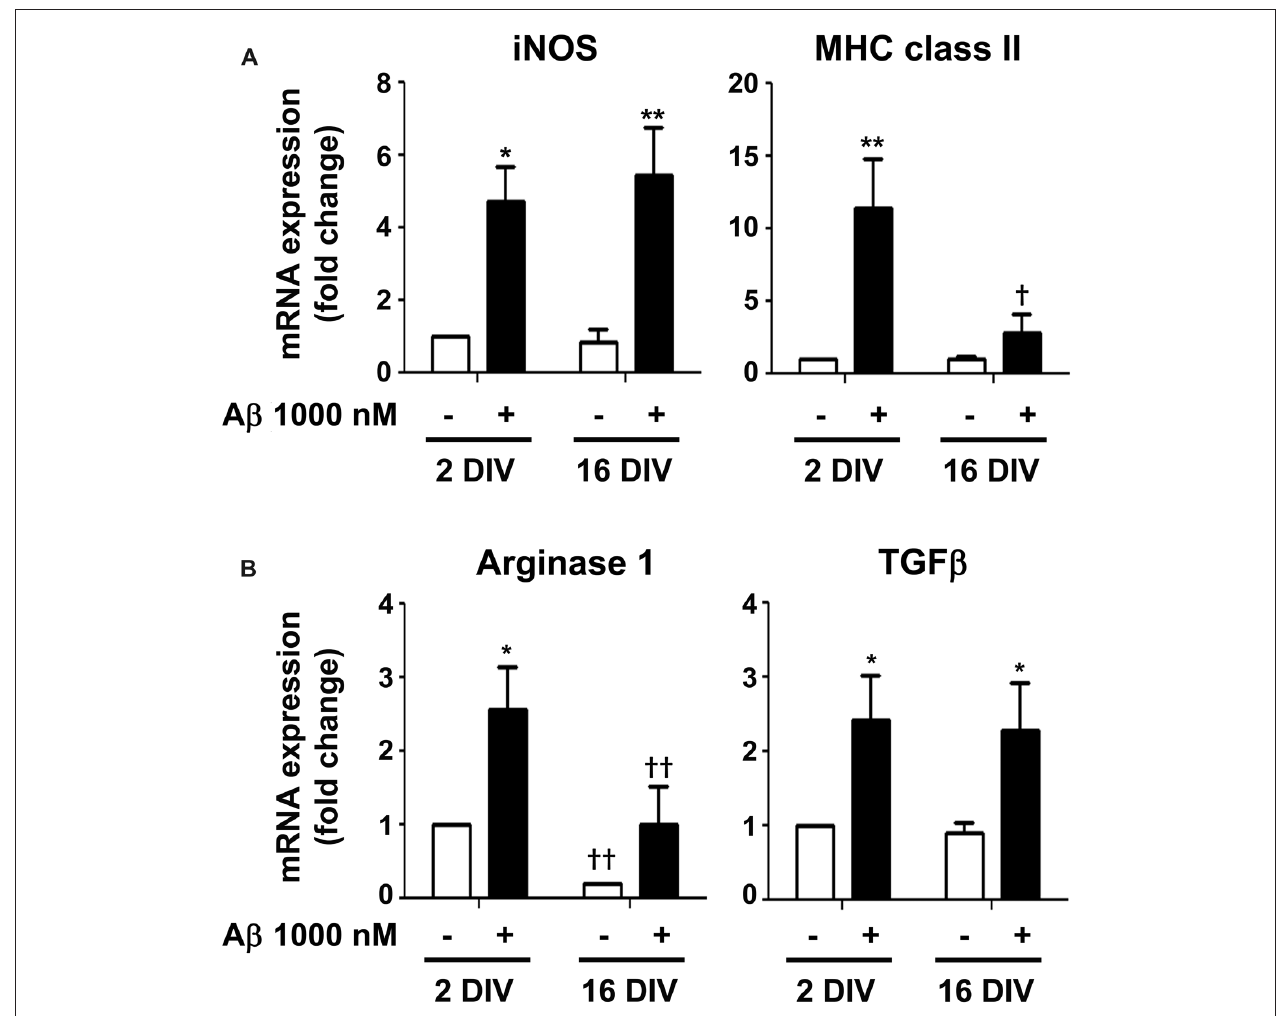
FIGURE 10 | Mixed representation of M1/pro-inflammatory and M2/anti-inflammatory polarization markers in 2 and 16 days in vitro (DIV) microglia treated with amyloid- β (A β ) peptide suggests the presence of different cell subsets. Microglia that were kept in culture for 2 and 16 DIV were treated with 1000 nM A β for 24 h. (A) Expression of M1/pro-inflammatory [e.g., inducible nitric oxide synthase (iNOS) and major histocompatibility (MHC) class II] and of (B) M2/anti-inflammatory [e.g., Arginase and transforming growth factor β (TGF β )] was evaluated by Real-Time PCR. Results are expressed in graph bars as mean ± SEM. Cultures, n = 4 per group. Two-way ANOVA ( Post hoc Bonferroni test): ∗ p < 0.05 and ∗∗ p < 0.01 vs. respective non-treated Control; † p < 0.05 and †† p < 0.01 vs. 2 DIV cells; (A) MHC class II: DIV × A β interaction F ( 4.53 ) , p <